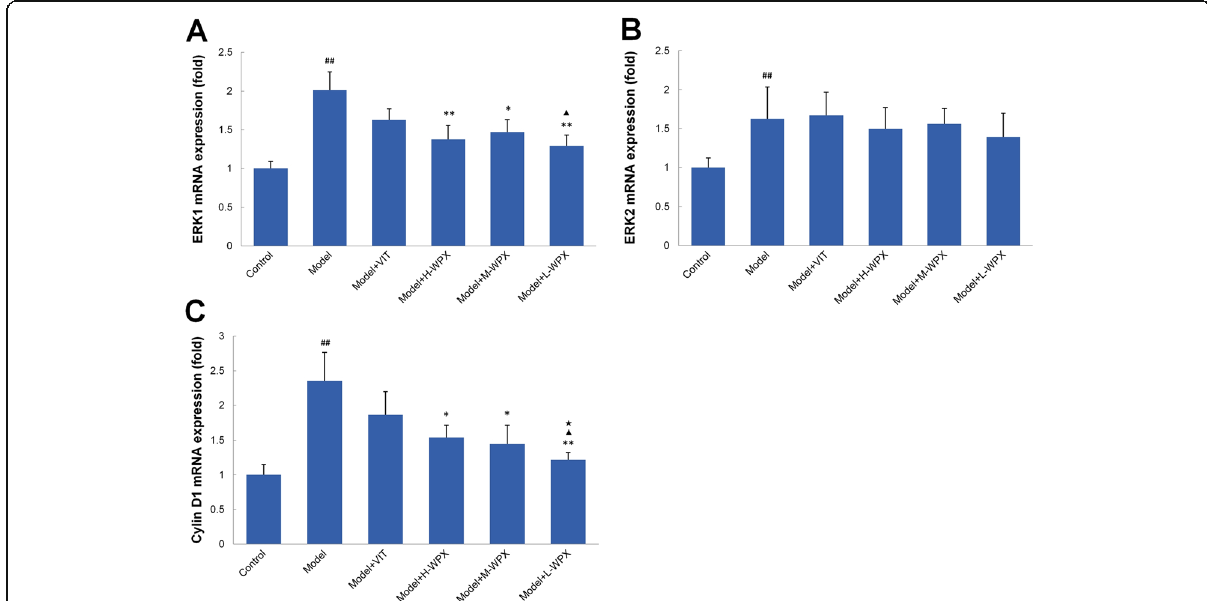
Fig. 9 Effect of WPX on the mRNA levels of ERK1, ERK2 and Cyclin D1 in gastric epithelial cells. a ERK1 mRNA levels of gastric epithelium in various groups. b ERK2 mRNA levels of gastric epithelium in various groups. c Cyclin D1 mRNA levels of gastric epithelium in various groups. The results are expressed as mean±SD ( n =9 in each group). Note: ## P <0.01, vs Control; ** P <0.01, ** P <0.05, vs Model; ▲ P <0.05, vs VIT; ★ P <0.05, vs